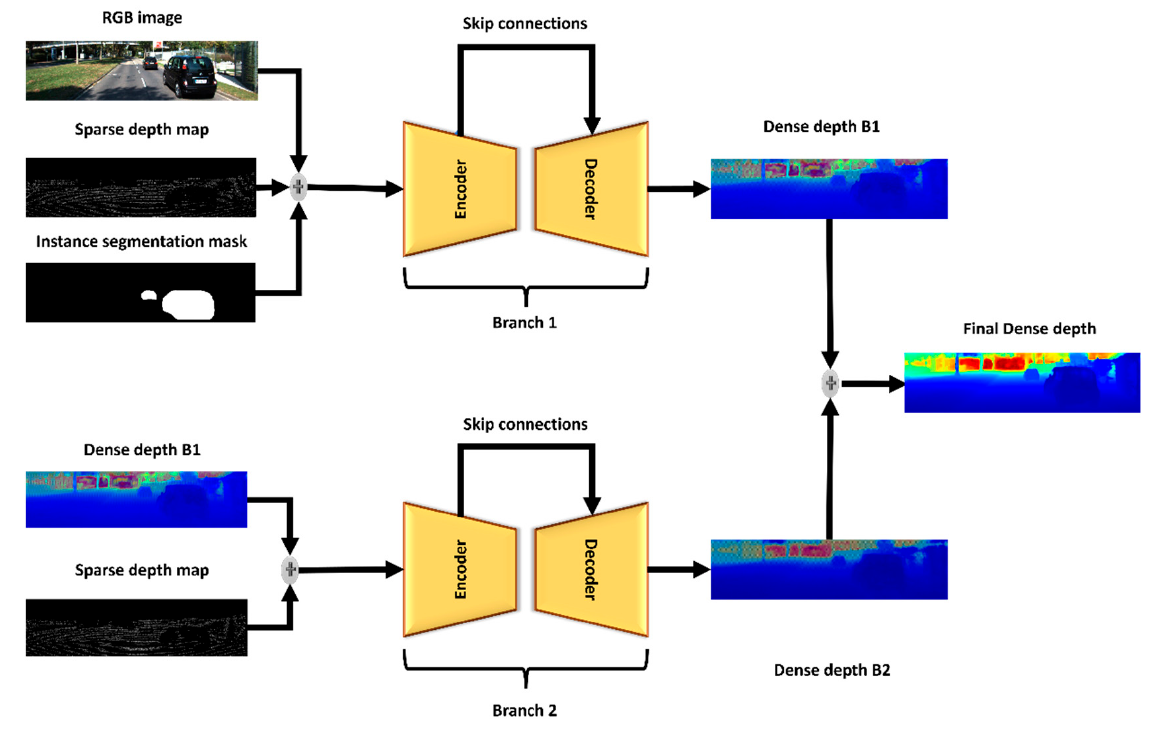
Figure 6. The network architecture of the proposed method with three distinct inputs: RGB image, the sparse depth map, and instance segmentation features, and two encoder–decoder branches with skip connections. Depth maps are color encoded for better visualization. Cold colors represent near objects, while warm colors represent distant objects. Table 2. Depth deep neural network encoder and decoder configuration.